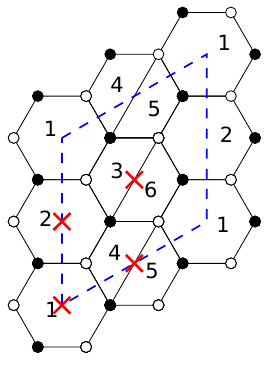
Figure 6 . PdP 3 c dimer with orientifold